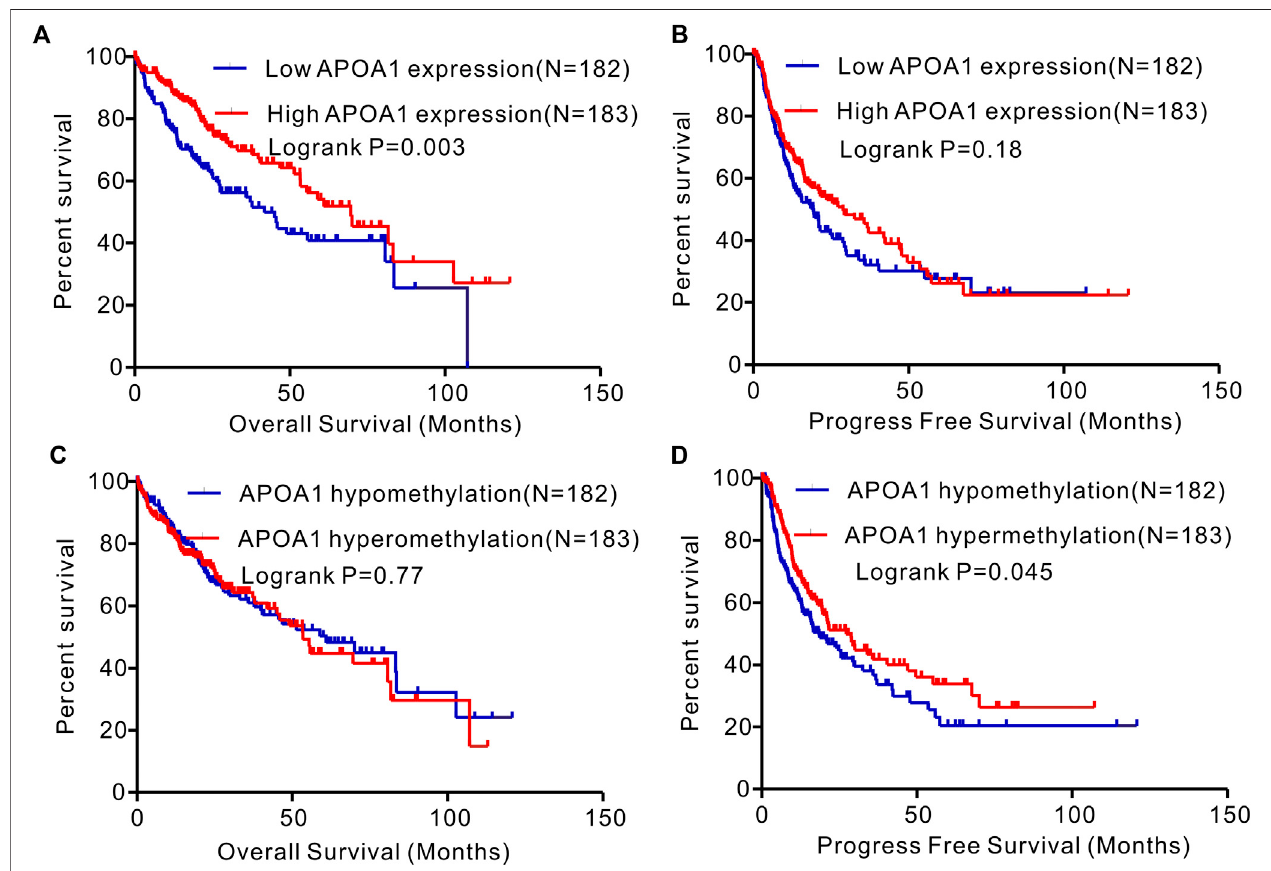
FIGURE6| Kaplan – Meier curves ofOSand PFSinpatientswithHCC intheTCGA database. (A) High expression APOA-1 isassociatedwithbetterOSin patients with HCC; (B) but not associated with PFS. (C) APOA-1 hypermethylation is not correlated with OS in patients with HCC; (D) but correlated with favorable PFS.